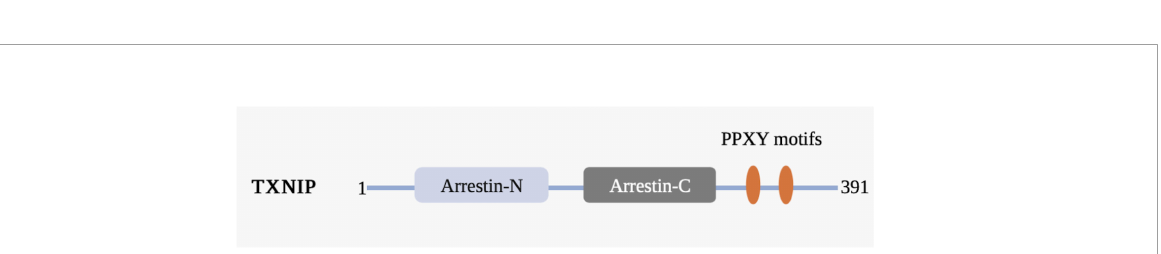
FIGURE 2 Schematic representation of the TXNIP domain organization. TXNIP contains amino acids 1 − 391. The a -arrestin TXNIP domain comprises a N- terminal domain (arrestin-N) and a C-terminal domain (arrestin-C), the C-terminal tail of which contains two PPxY motifs (yellow). Numbers indicate amino